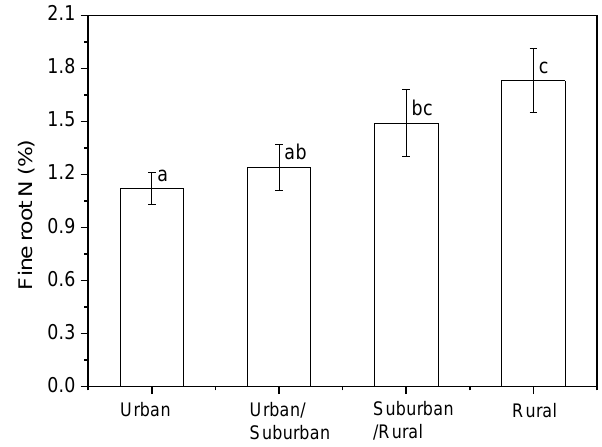
Fig 5. Comparisons of N concentration in live fine root (0-10 cm soil layer) among four 524 Fig. 5. Comparisons of N concentration in living fine root (0–10cm soil layer) among four urbanization gradient classes. Error bars indi- urbanization gradient classes. Error bars indicate ± 1 S.E. (N = 3 for urban and rural, N=4 for 525 cate ± 1 S. E. ( N = 3 for urban and rural, N = 4 for urban/suburban and suburban/rural). The different letters denote significant differ- urban/suburban and suburban/rural). Different letters denote significant difference ( P ≤ 0.05) 526 ences ( P ≤ 0.05) between gradient classes (SNK between gradient classes (SNK test). 527